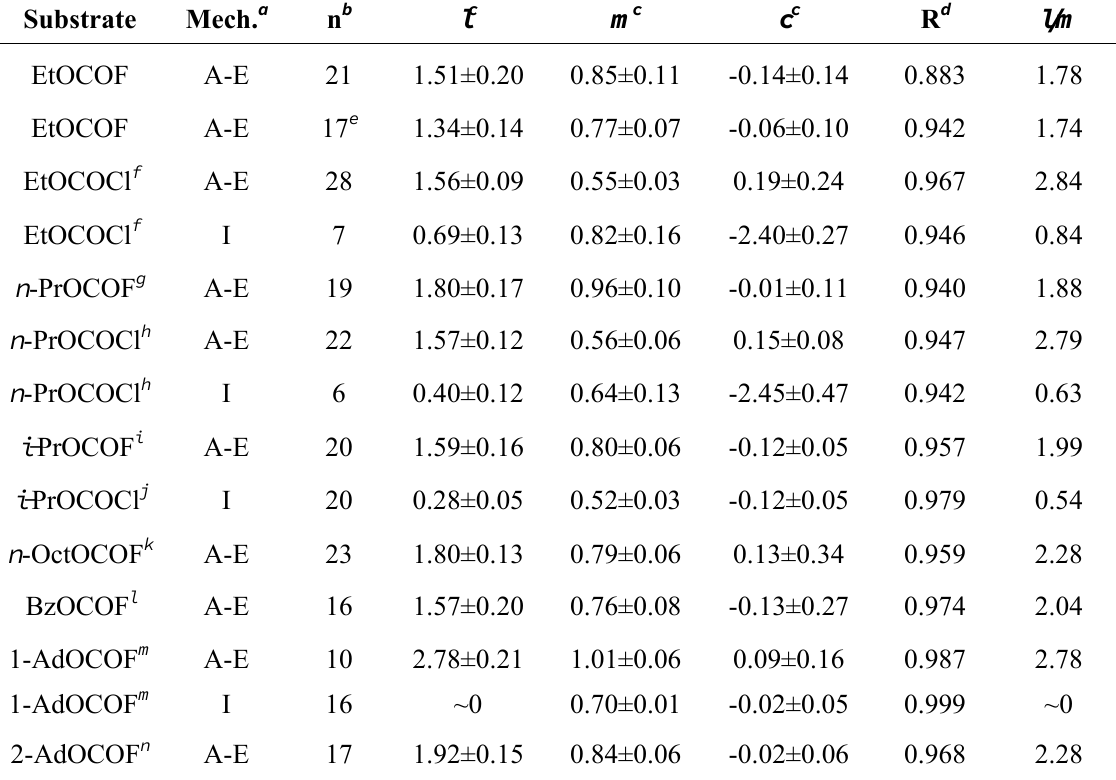
Table 4. Correlation of the specific rates of solvolysis of ethyl fluoroformate and a comparison with the corresponding values for the solvolyses of other halogenoformate esters using the extended Grunwald-Winstein